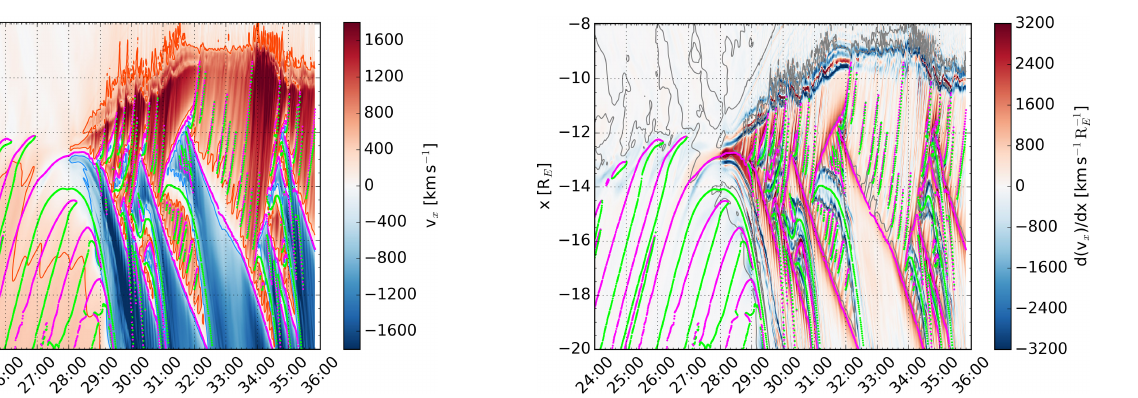
Figure 4. The derivative of V x with respect to x and the curves are contours of zero total pressure in the x direction ( P tot ,x = P dyn ,x + (cid:49)P mag ,x + (cid:49)P the ,x = 0) as a function of x and time in minutes after the beginning of the simulation (MM:SS). Magenta and green dots show the locations of the X and O points,